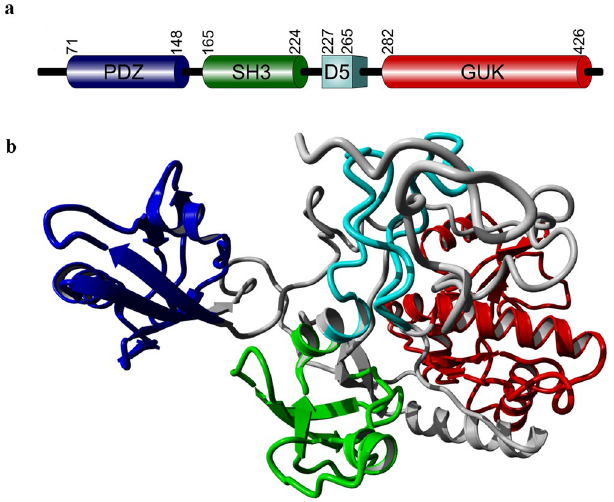
Figure 1. Structure of MPP1. Schematic representation ( a ) of the overall domain composition and ribbon model ( b ) of the structure of MPP1. PDZ blue, SH3 green, D5 light blue, GUK red. Domain boundaries were marked based on Quinn et al. 11 . Structural model redrawn according to Listowski et al. 44